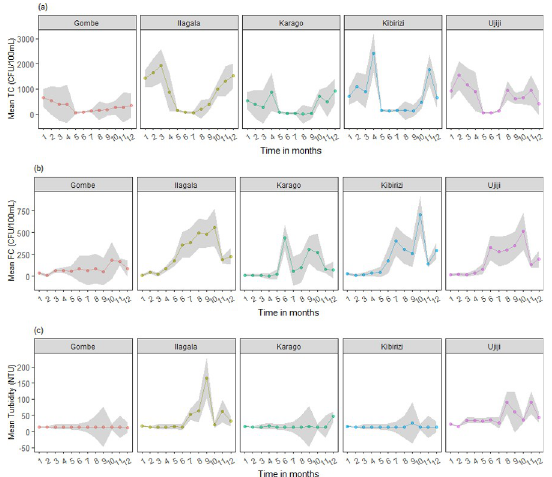
Fig 2. Monthly mean concentrations (in line) ± standard deviation (shaded area) of coliforms and turbidity determined by citizen scientists in each study site. (a) Mean total coliform counts (CFU/100 mL) ± standard deviation, (b) Mean fecal coliform count (CFU/100 mL) ± standard deviation (c) Mean turbidity (NTU) ± standard deviation.